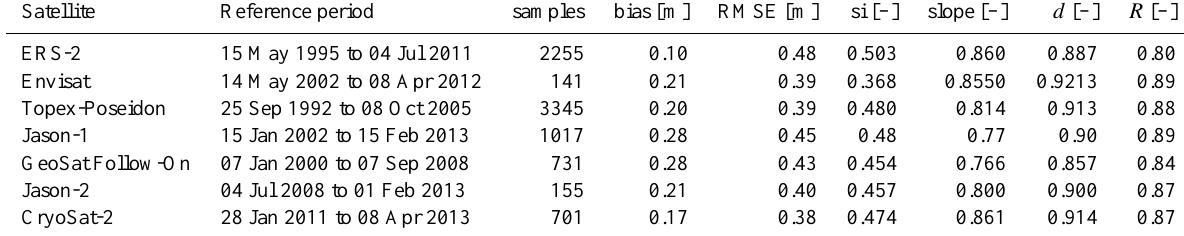
Table 2. Performance indices of the SWAN model: comparison between the SWAN data and satellite data. Satellite